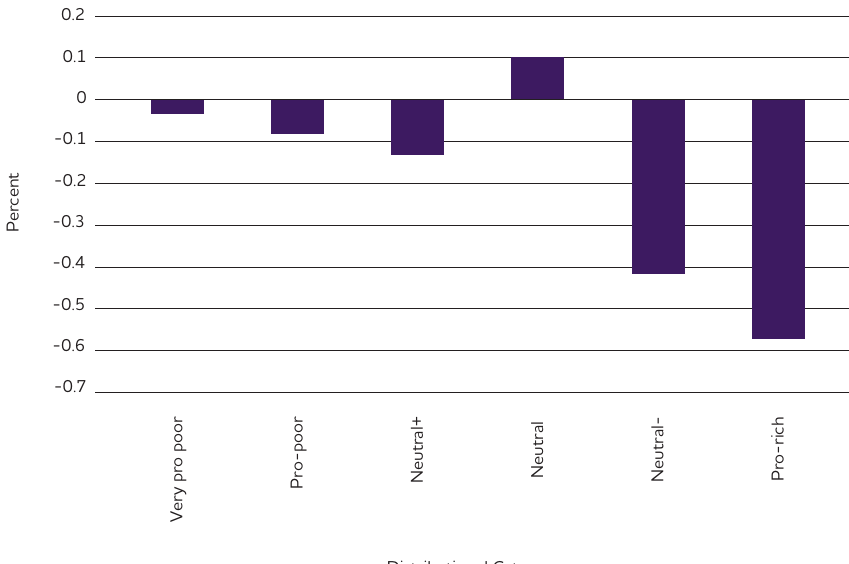
Figure 19 examines real-terms changes in terms of absolute £million. The largest absolute cuts are also in ‘neutral-minus’ and ‘pro-poor’ services, although it is the former that are larger here. Figure 19 also highlights that ‘pro-poor’ and ‘very pro-poor’ services have seen substantial savings in absolute terms. The reason for this different picture is that the categories of service along the pro-rich to pro-poor spectrum vary quite a lot in terms of the base scale of expenditure. Pro-poor services account for a much larger share of expenditure in total. We show this clearly in relation to the case studies in the following